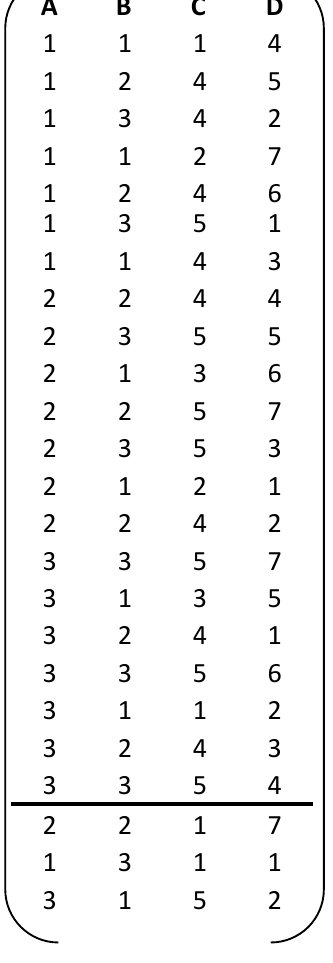
Figure 13. EA (24, 3 2 5 1 7 1 ).